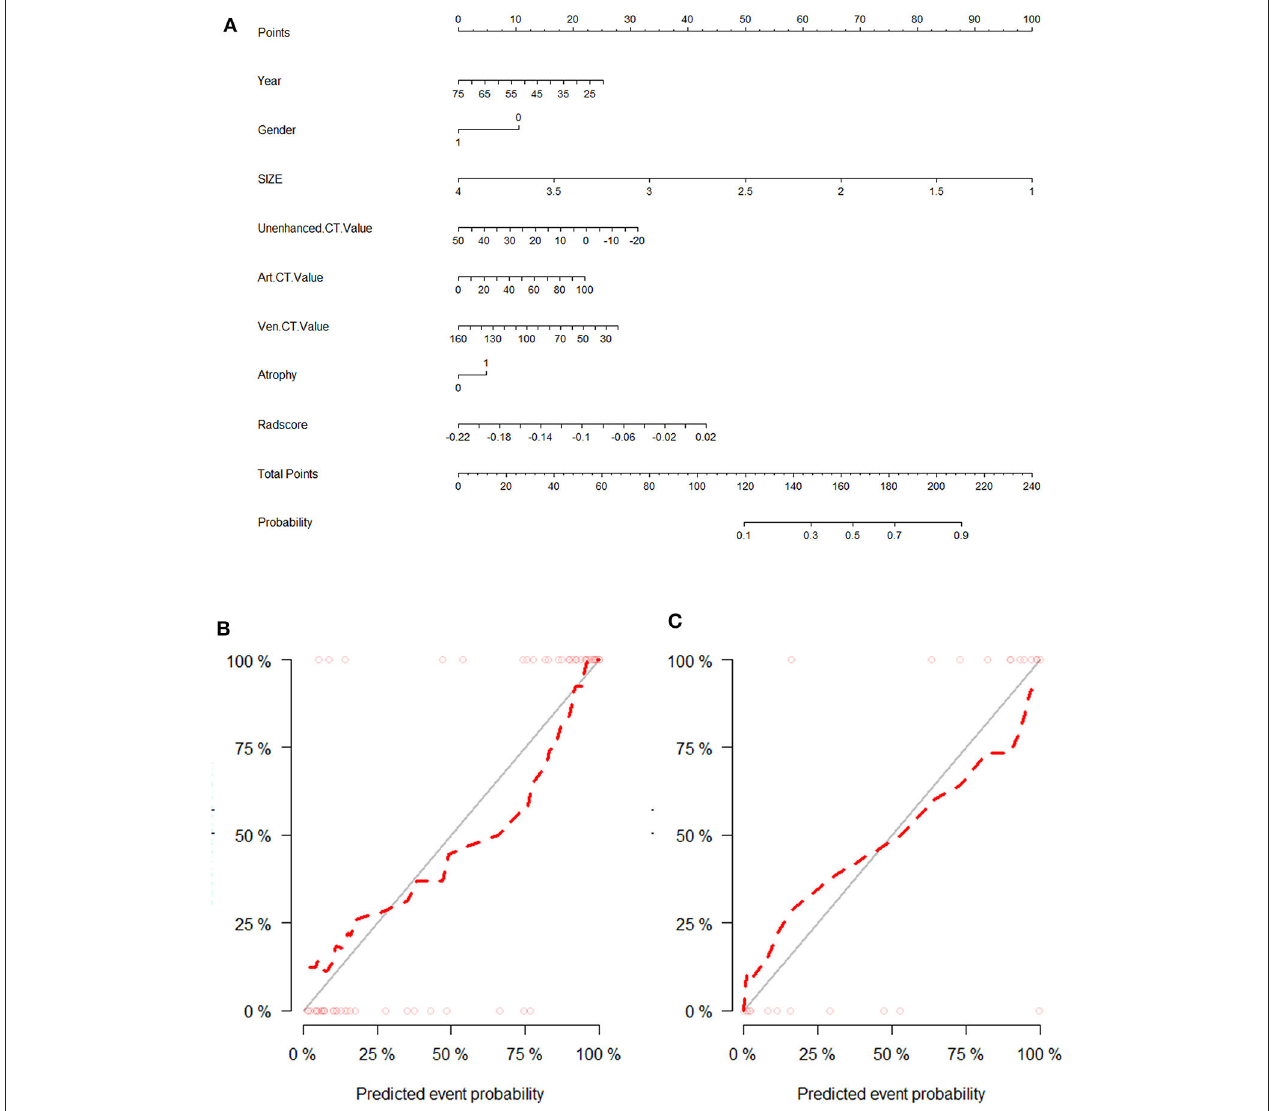
FIGURE 6 | The visual presentation of nomogram combining the radiomics signature and clinic–radiological indicators (A) and its calibration curves in training cohort (B) and test cohort (C) .